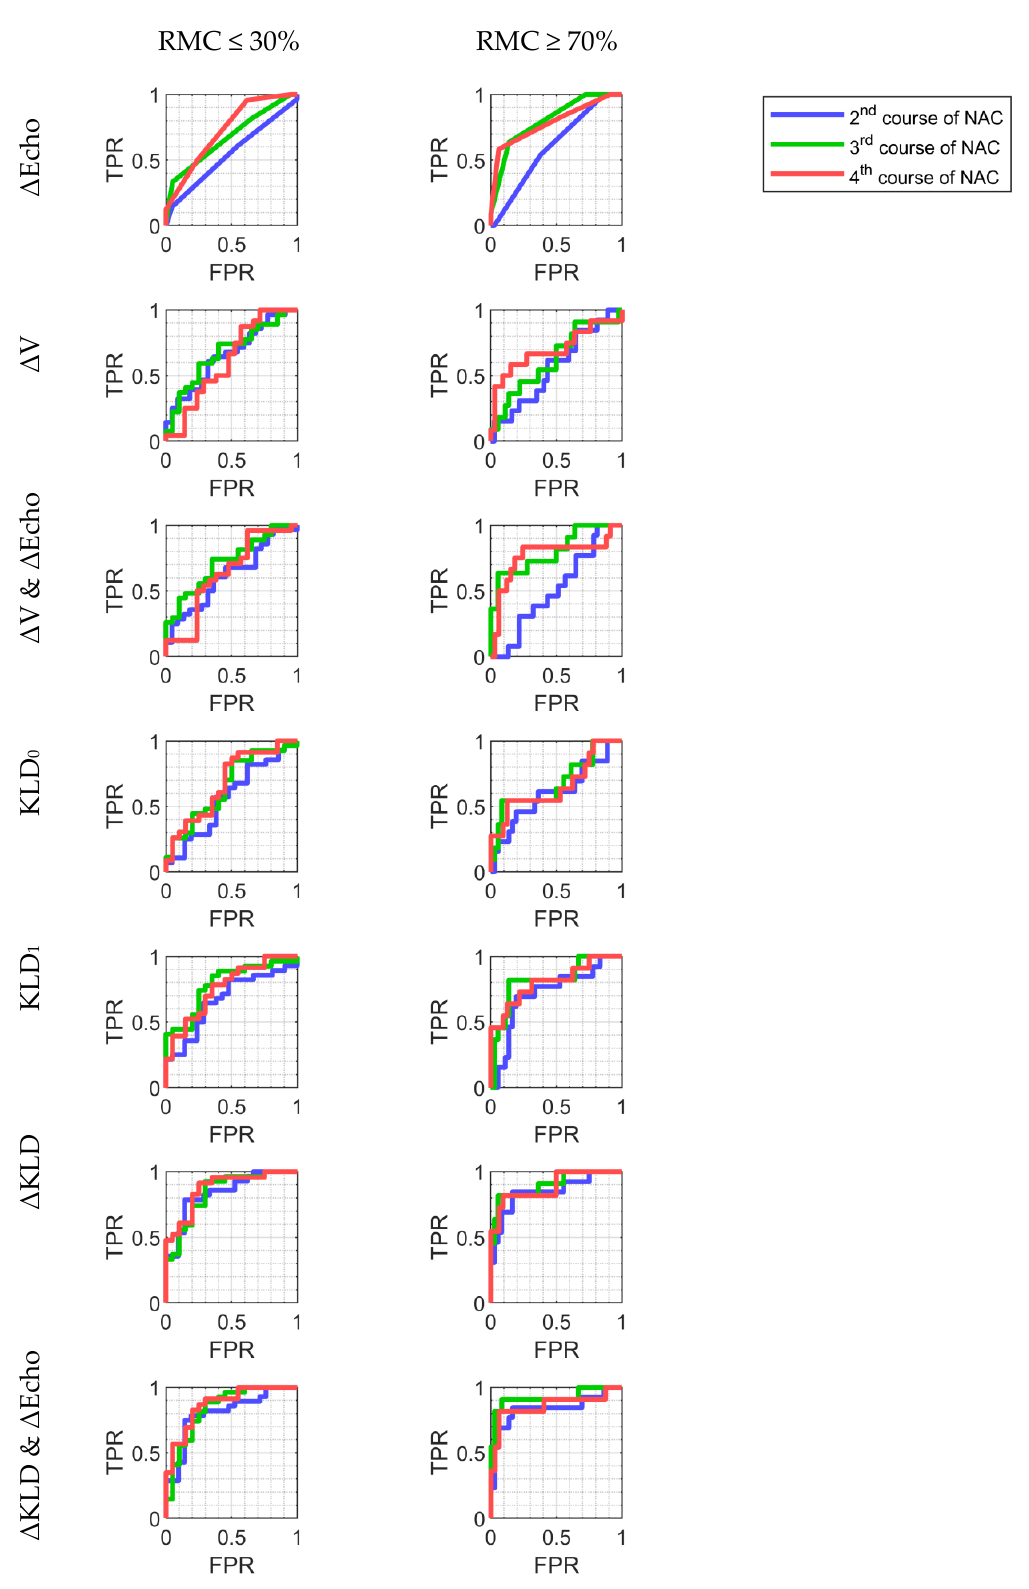
Figure A1. ROC curves for the examined classifiers and four RMC thresholds.